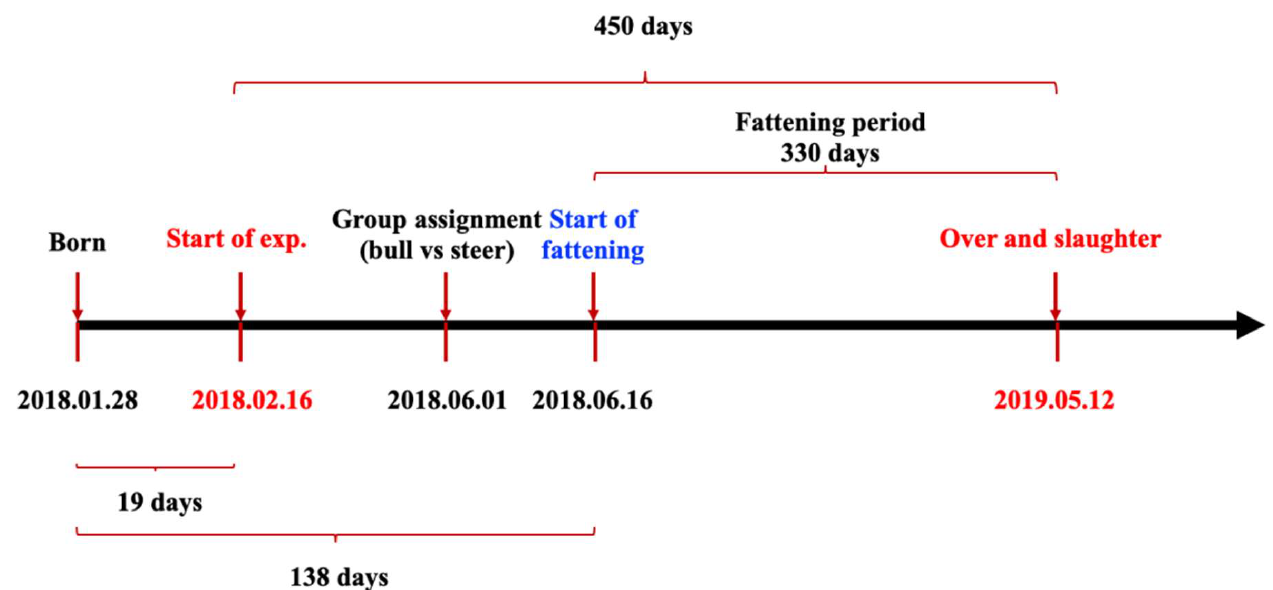
Figure 1. Timeline of the experimental design of this study. Table 1. Ingredient composition and nutrient levels of diets (DM